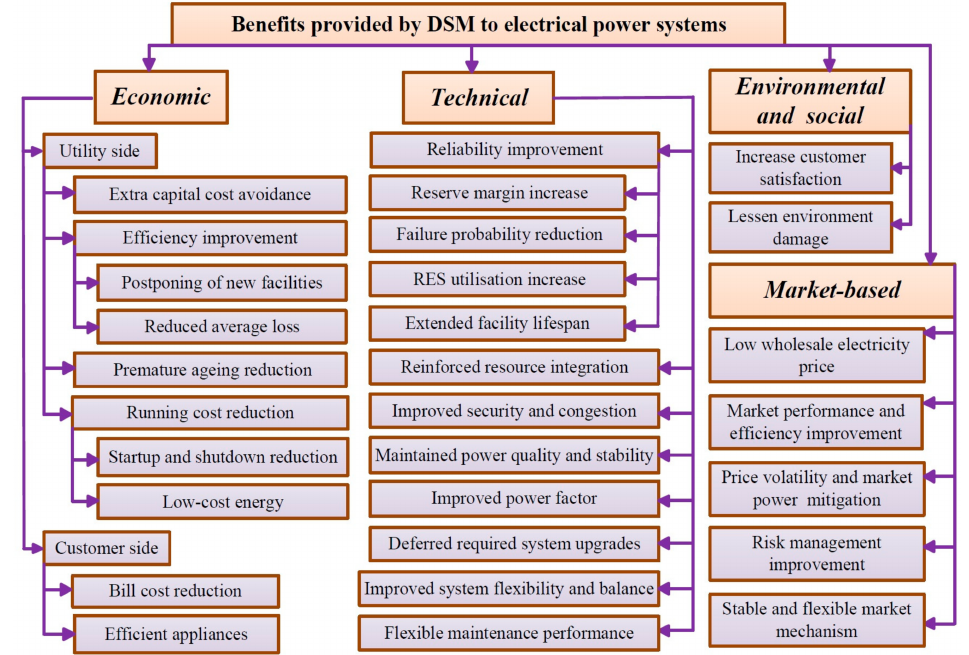
Figure 2. Benefits achieved by the DSM